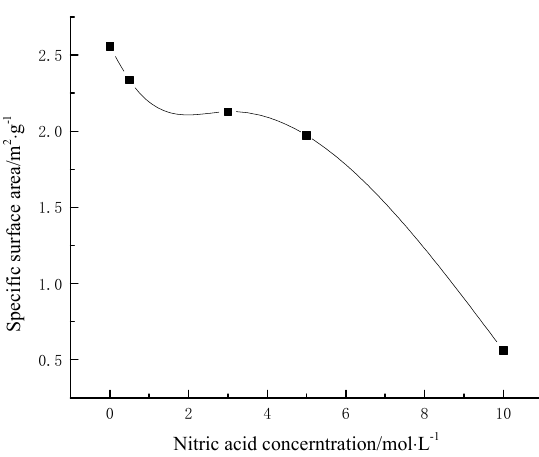
Figure 2. Specific surface area of lignite treated with different nitric acid concentrations.